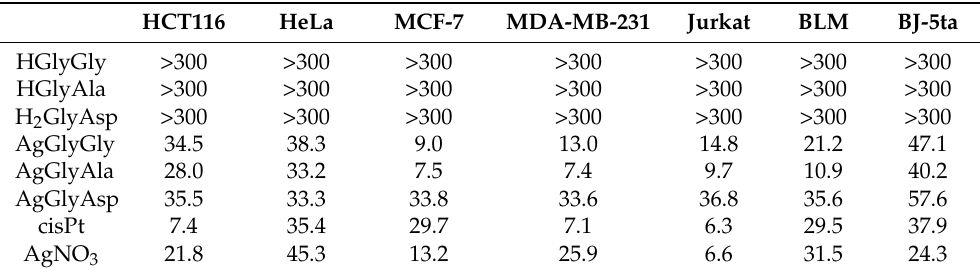
Table 5. Anticancer activity of free ligands HGlyGly, HGlyAla, and H 2 GlyAsp and silver(I) dipeptide complexes (IC 50 : µ